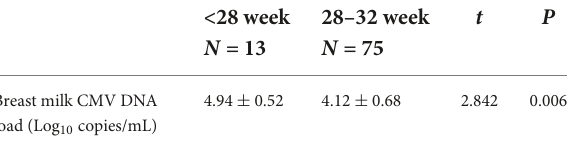
TABLE 2 Comparison of cytomegalovirus (CMV) load in breast milk during peak detoxification